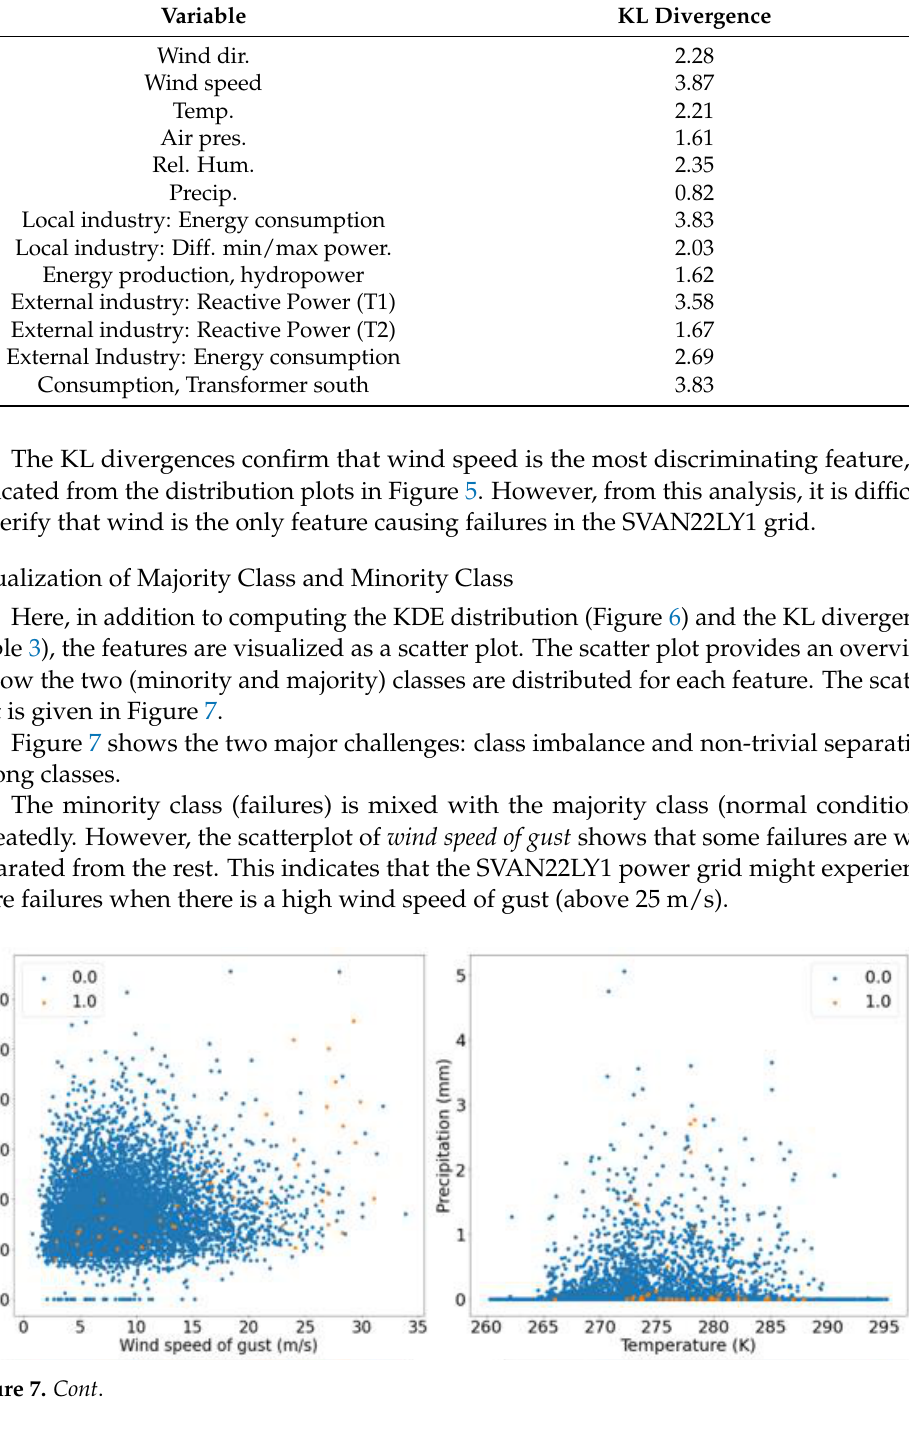
Figure 7. Scatterplot of the two classes for different features. Figure 7 shows the two major challenges: class imbalance and non-trivial separation among classes. The minority class (failures) is mixed with the majority class (normal conditions) re- peatedly. However, the scatterplot of wind speed of gust shows that some failures are well separated from the rest. This indicates that the SVAN22LY1 power grid might experience more failures when there is a high wind speed of gust (above 25 m/s). In summary, the difficulty in separating the two classes by using simple thresholds on the individual variables motivates the use of more advanced ML techniques. 6.2. Classification Performances Here, the classification performances obtained by the different methods are com- pared. In Table 4, the performances of the different models are compared across the five folds in terms of the average number of TN, FP, FN, TP, and the weighted F1 score.